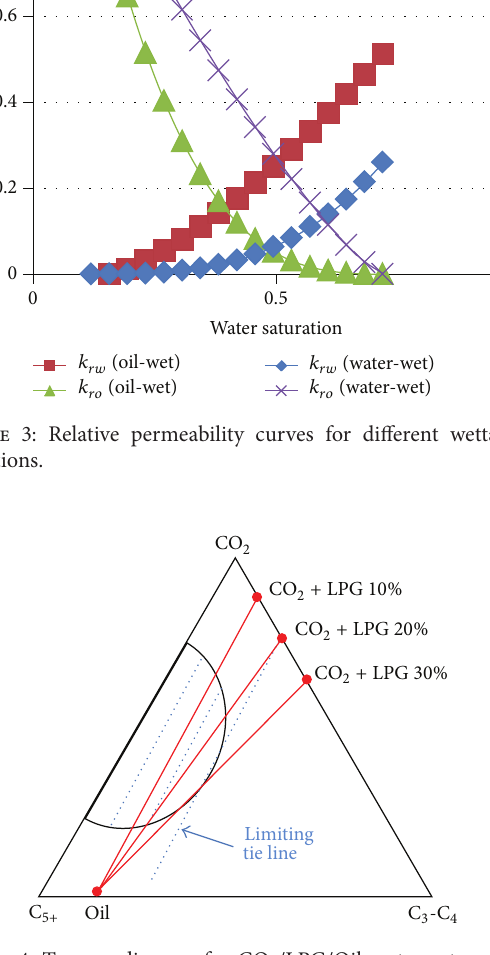
Figure 4: Ternary diagram for CO 2 /LPG/Oil system at reservoir pressure 1,500